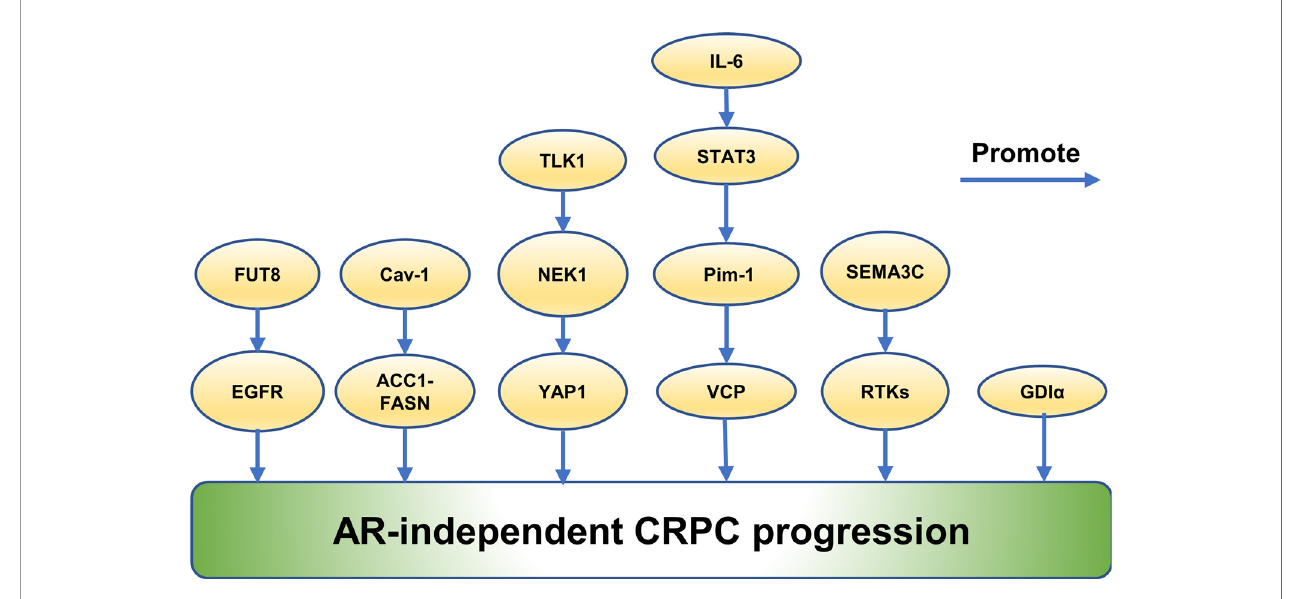
FIGURE 5 | Emerging proteins mediate CRPC progression via AR-independent